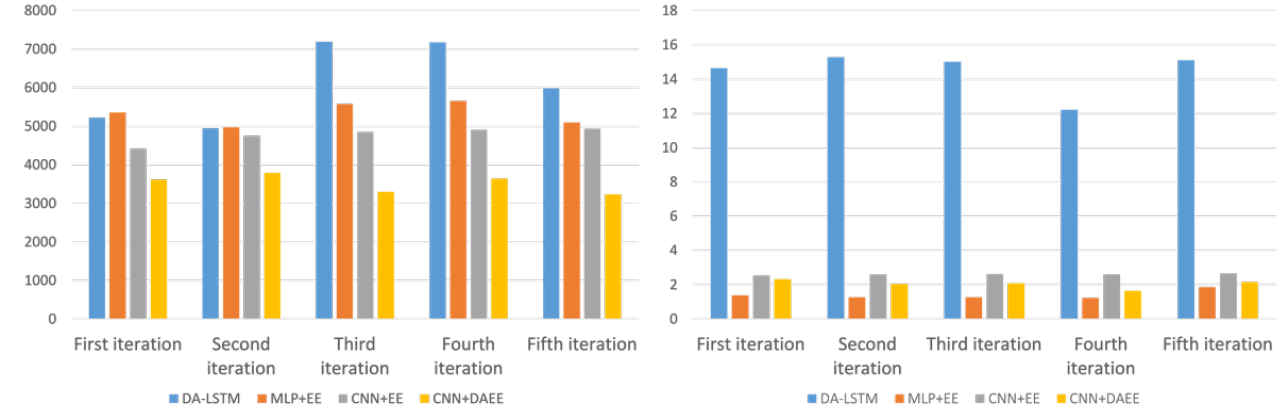
Figure 12. MAE in units of minutes ( left ) and training duration in units of hours ( right ). Table 10. Mean training duration and MAE in units of minutes across five iterations of